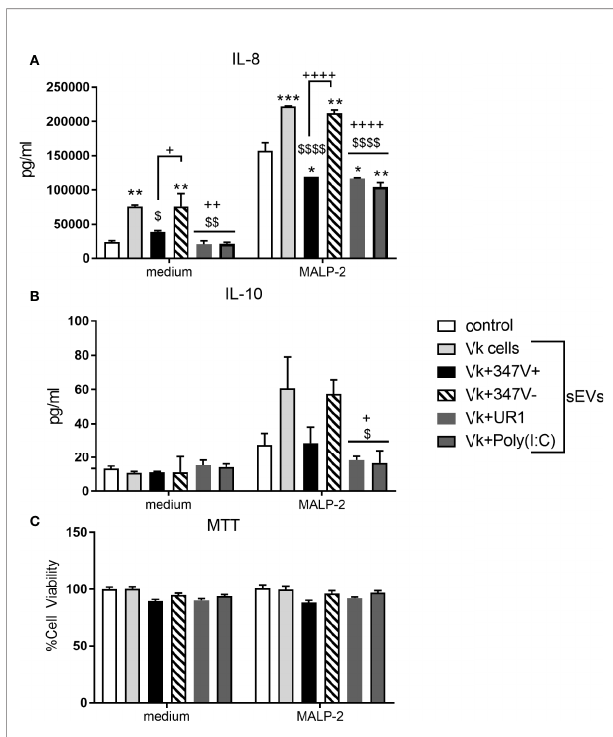
FIGURE 3 | sEVs from TV-infected vaginal cells regulate cellular immunity in a manner dependent on the viral status of the parasite. PBMCs were treated with control no sEV, sEVs derived from vaginal cells (Vk cells), Vk+347V+, Vk+347V-, Vk+UR1, and Vk+Poly(I:C) with or without MALP-2 for 24 h. (A) IL-8 and (B) IL-10 protein levels were measured by MSD assay. (C) MTT assays were performed to con fi rm cell viability after 24 h treatment relative to control. Graphs represent data from PBMC donor A in duplicate and plotted as mean ± standard error of mean. *p < 0.05; **p < 0.01; and ***p < 0.001 represent sEVs different from control. $ p < 0.05; $$ p < 0.01; and $$$$ p < 0.0001 represent comparisons different to Vk cells sEVs. +p < 0.05; ++p < 0.01; and ++++ p < 0.0001 represent comparisons different to Vk+347V-